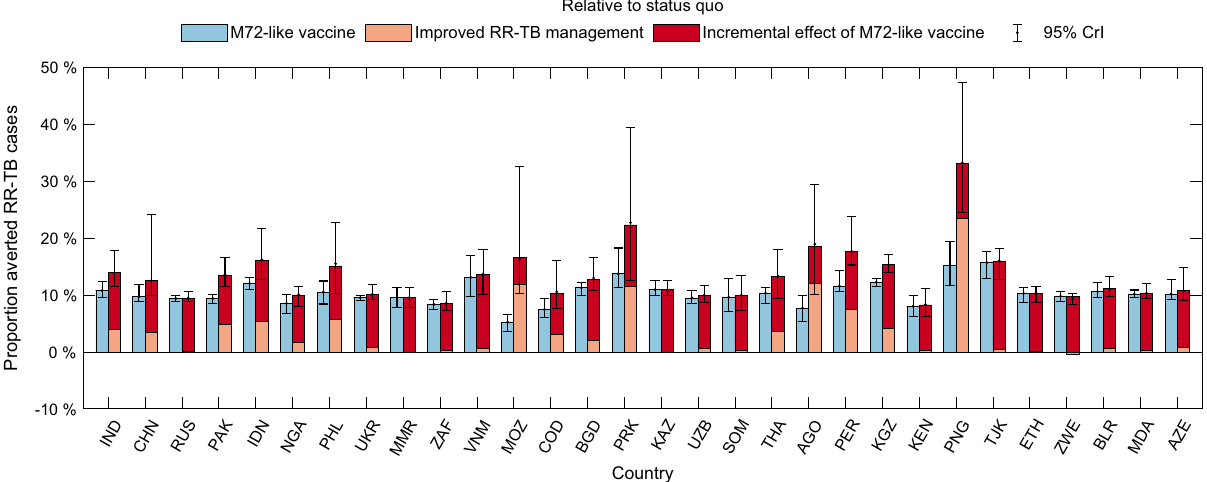
Fig. 3 Projected percent cases of RR-TB averted by an M72-like vaccine. Rectangular bars show median estimates and error bars show 95% Bayesian credible intervals (CrIs), both estimated from n = 200 posterior samples for each country. Blue bars show the vaccine-avertable proportions of rifampicin- resistant tuberculosis (RR-TB) cases relative to a ‘ status quo ’ scenario, while adjacent bars together show averted proportions in combination with ‘ improved RR-TB management ’ , as outlined in the caption to Fig. 1. The latter bars are strati fi ed to show: (i) the impact of improved management of RR-TB alone, i.e. in the absence of vaccination (orange segment), and (ii) the incremental impact of vaccination, acting in combination with these improvements (red segment). Error bars on the stacked orange and red bars show the 95% CrIs of the total impact of a vaccine combined with improved management of RR-TB. Countries are ranked in a descending order according to the number of RR-TB incident cases in 2018.